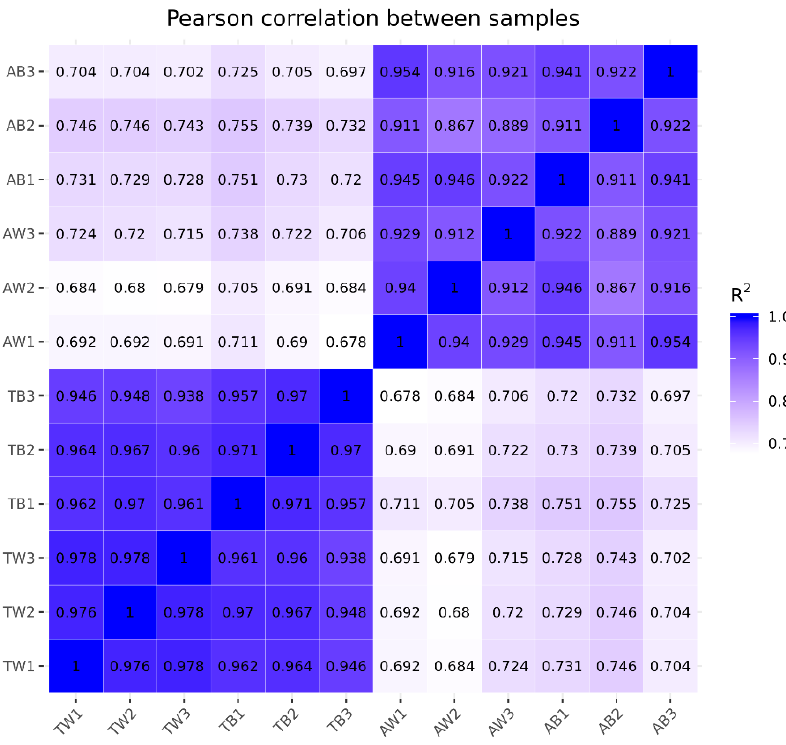
Figure 2. Sample correlation heat map. The horizontal and vertical coordinates are the squared correlation coefficients of each sample.